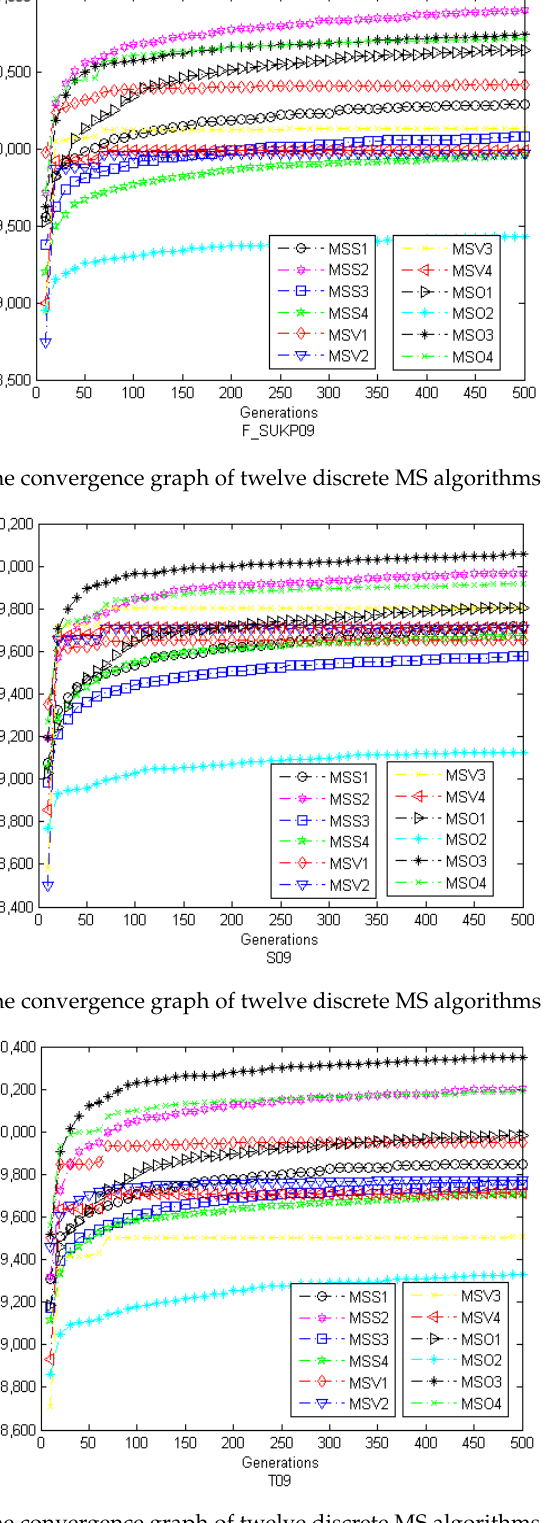
Figure 9. The convergence graph of twelve discrete MS algorithms on T09.